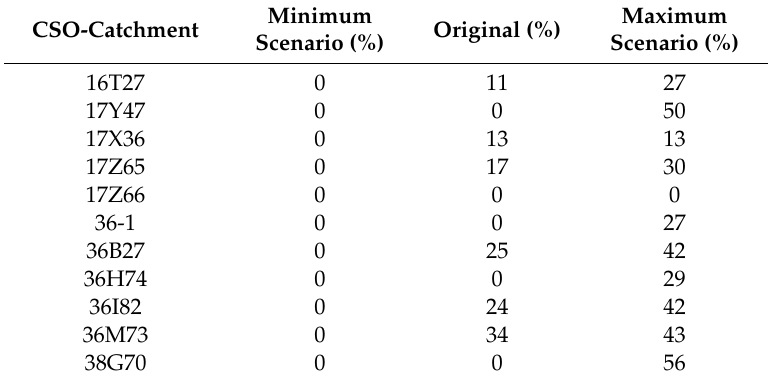
Table 2. Meshness of the three analyzed scenarios for each of the CSO-catchment in the study